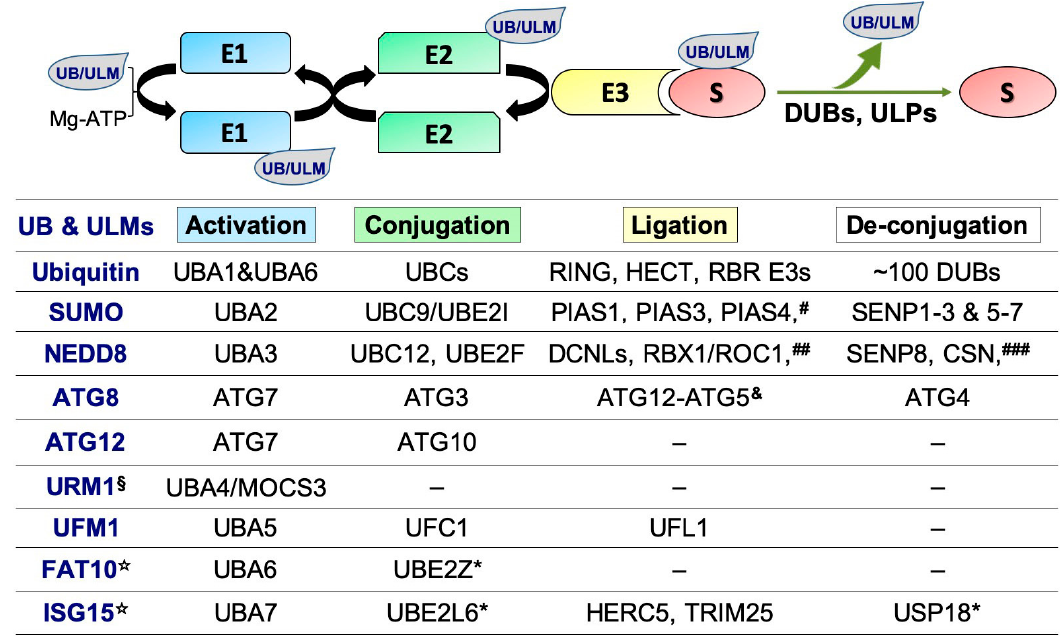
Figure 2. The ubiquitin and ULM conjugation cascade/s and the regulatory enzymes. * These enzymes also work in the ubiquitin pathway [47,50]. # In addition to the listed E3s, several other proteins were reported to function as SUMO E3 ligases, including RanBP2, ZNF451, TRIM28/KAP1, PML, and the polycomb protein Pc2 [51,52]. To note, in order to be conjugated (SUMOylated) to their cellular targets by the E1-E2-E3 cascade, SUMO proteins (SUMO1, SUMO2 and SUMO3) should first be terminally processed from their corresponding precursor forms by SUMO-specific cysteine proteases (SENPs). This processing exposes two C-terminal glycine residues of SUMO proteins and generates their mature forms which can be bound by E1. Essentially, SENPs also possess isopeptidase activity, which is critical for de-conjugation of SUMO proteins from their substrates and SUMO recycling [53]. ## Other E3s which have been reported to promote NEDD8 conjugation (neddylation) include RBX2/ROC2/SAG, MDM2, c-CBL, Parkin, IAPs, RNF111, TRIM40, and SCF FBXO11 [54]. ### The deneddylases which could also remove NEDD8 from the modified proteins include Ataxin-3, USP21, UCH-L1 and UCH-L3 [55]. & The Atg12-Atg5 functions as an E3, promoting the conjugations of phosphatidylethanolamine (PE) to ATG8. The lipidated ATG8 (ATG8-PE) plays essential roles in autophagosome formation and selective cargo recognition during autophagy. It is recycled by ATG4 protease [56–58]. § Ubiquitin-like modifier URM1 acts as a sulphur carrier in the process of eukaryotic transfer RNA (tRNA) modification [59,60]. ☆ In contrast to ubiquitin and other ULMs, ISG15 and FAT10 comprises two ubiquitin-like domains joined by a flexible linker [61]. There is accumulating evidence showing that ubiquitin and ULMs could generate hybrid chains, which seem to confer improved specificity and affinity towards their cognate receptors and to diversify the “ubiquitin code” [62]. ATG, autophagy-related gene; CSN, COP9 signalosome; DCNLs, DCN1-like proteins; DUBs, deubiquitinases; EFP; estrogen-responsive finger protein; ISG15, interferon stimulated gene product 15; NEDD8, neural precursor cell expressed, developmentally down-regulated 8; NEDP1, NEDD8-specific protease 1; PIAS, protein inhibitor of activated STAT; SENP, sentrin specific proteases; S, substrate; SUMO, small ubiquitin-related modifier; TRIM, tripartite motif-containing protein; UB, ubiquitin; UBA, ubiquitin-activating enzyme; UBC, ubiquitin-conjugating enzyme; UFC1 , ubiquitin-fold modifier conjugating enzyme 1; UFL1, UFM1 specific ligase 1; UFM1, ubiquitin- fold modifier 1; ULPs, ubiquitin-like peptidases; URM1, ubiquitin-related modifier 1; USP18, ubiquitin-specific peptidase 18.